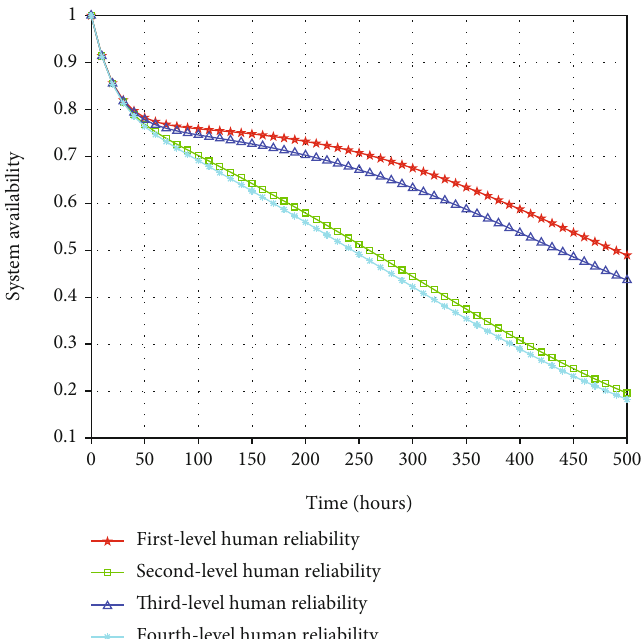
Figure 19: System availability trajectory with deteriorated failure and repair rates.